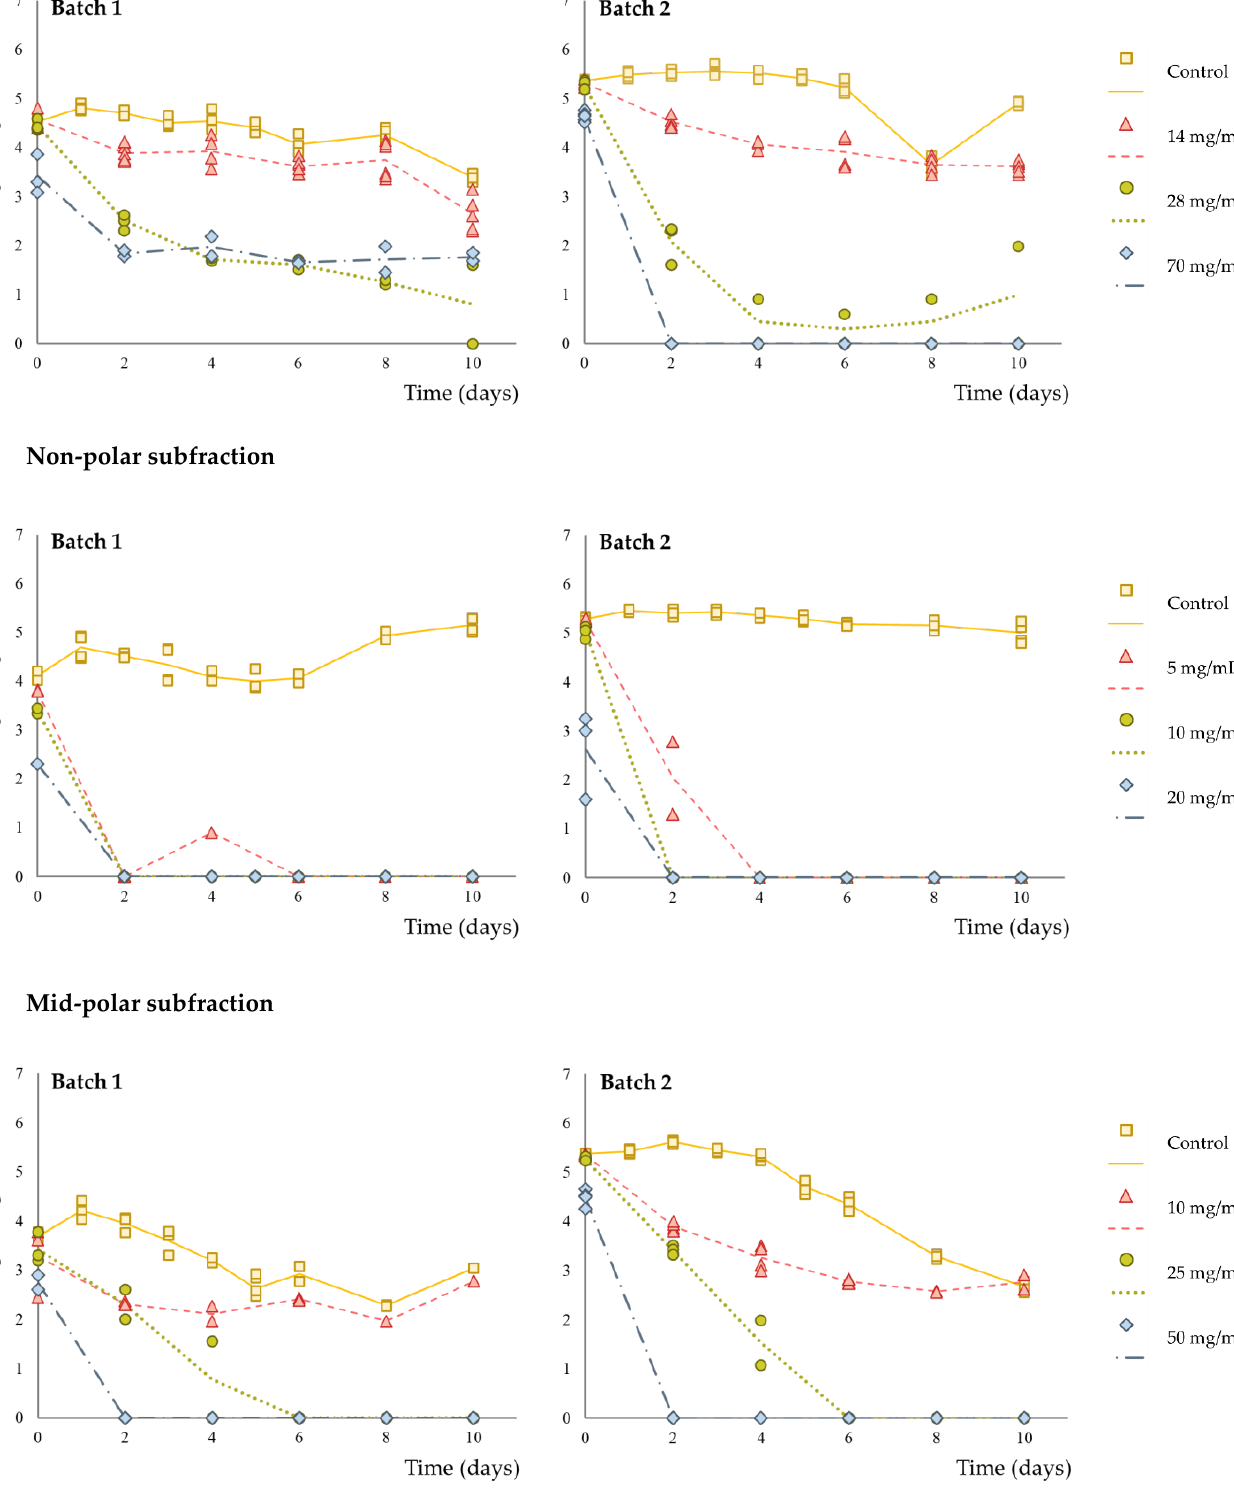
Figure 1. Behavior of B. cereus inoculated in fresh cheeses stored at 8 °C under E. selaginoides extracts exposure at the three concentrations for the two independent batches performed. Symbols represent the experimental observed data and lines the mean of observed data.